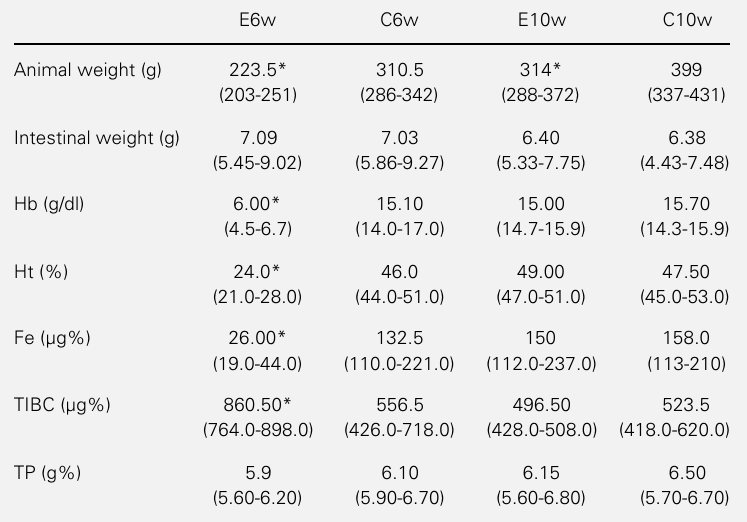
Table 1 - Effect of iron deficiency on animal weight, intestinal weight, hematocrit (Ht), hemoglobin (Hb), serum iron (Fe), total iron-binding capacity (TIBC) and total proteins (TP) for groups E6w (anemic), E10w (anemic and recovered), and controls (C6w and C10w). Data are reported as median and minimum and maximum values, within parentheses, for 10 rats in each group. 6w and 10w = No. of experimental weeks. *P<0.01 compared to the respective control (nonparametric Mann-Whitney